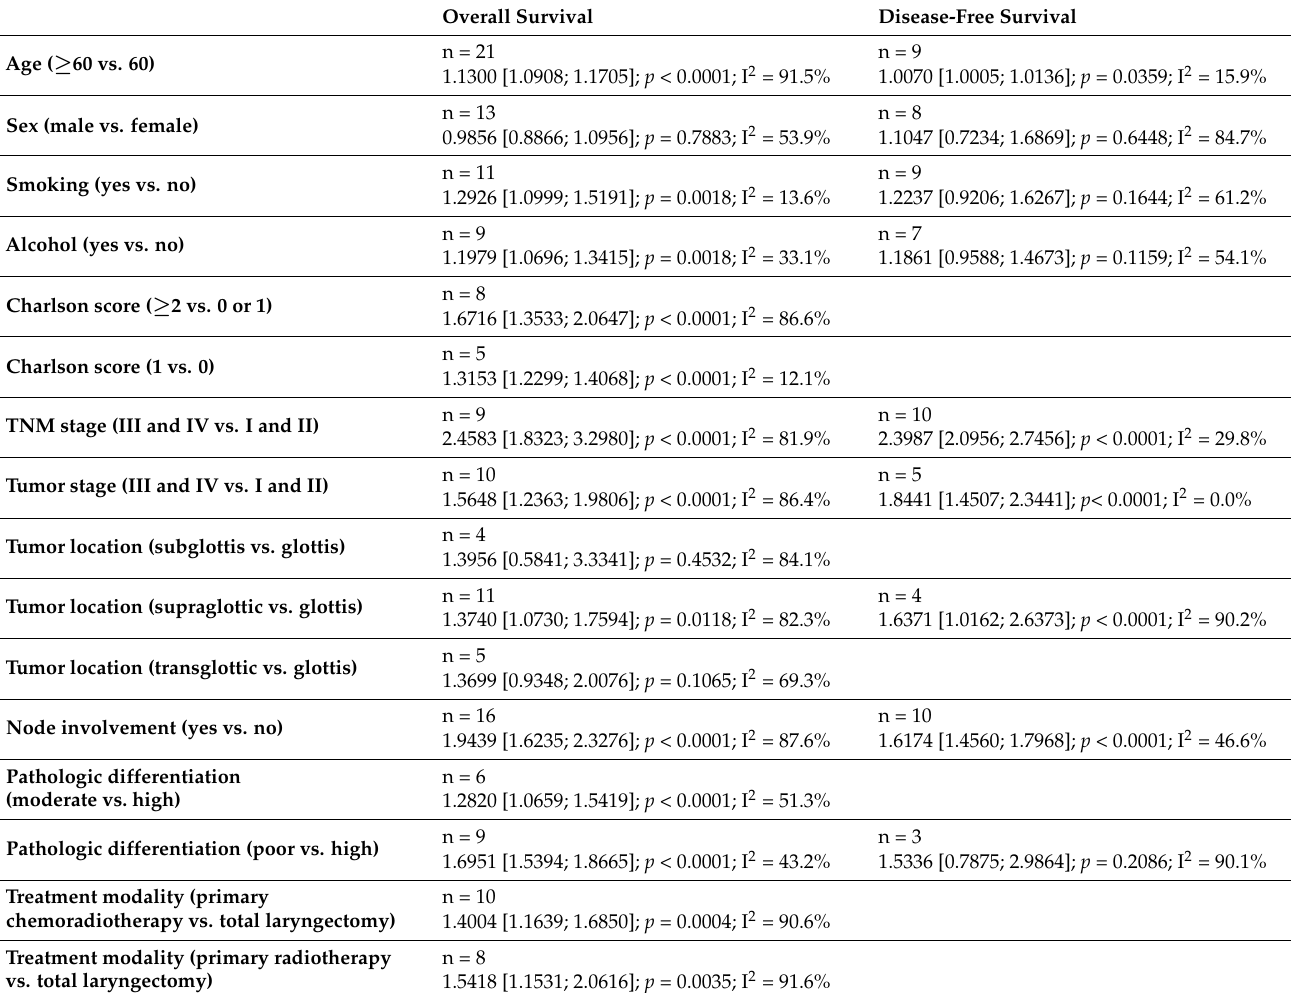
Table 2. Predictive values of various risk factors. Overall Survival Disease-Free